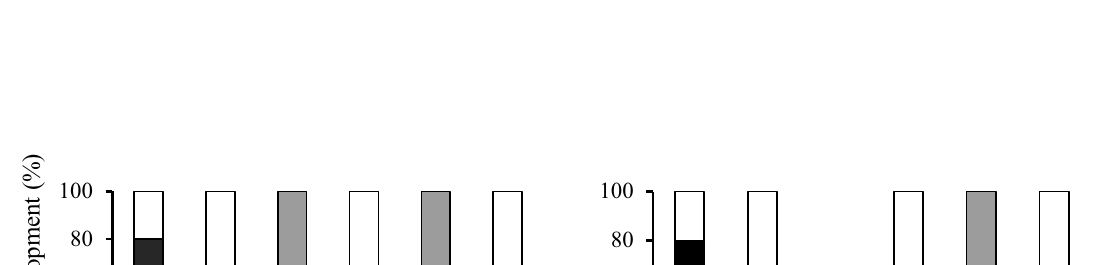
Figure 2. Histological description of the Pacific oyster C. gigas during 45 days of pre-conditioning in two experimental conditions. ( A ) Male in resorption stage (400 ×); ( B ) female in resorption stage (400 ×); ( C ) male in developing-early active stage (400 ×); ( D ) ripe male (400 ×); Ct conjunctive tissue, Dg digestive gland, Rspz residual spermatozoa, Rooc residual oocyte, Sc spermatocytes, Spz spermatozoa. Scale bar: 10 µm.